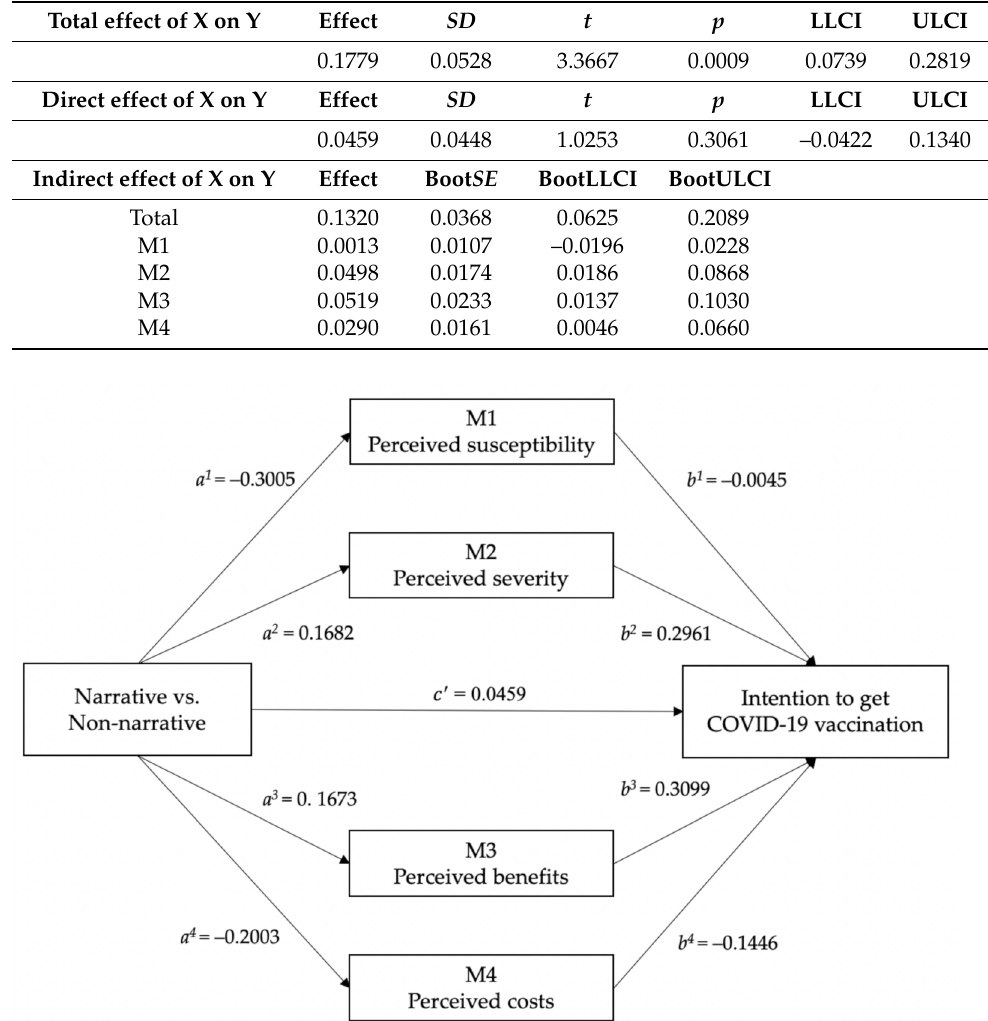
Figure 1. Mediating model on narrative